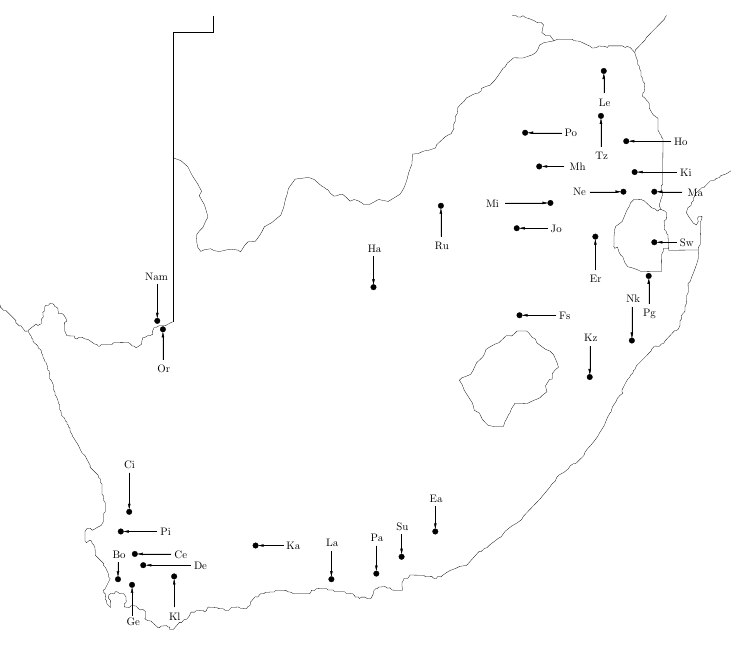
Figure 2: The 31 fruit production regions in South Africa. Table 2 contains the place names represented by 2 letter abbreviations in the figure. Pack house and cold store data for Namibia (Nam) and Swaziland (Sw) could not be found and are thus not considered in our model, even though fruit grown in those regions are generally exported via South